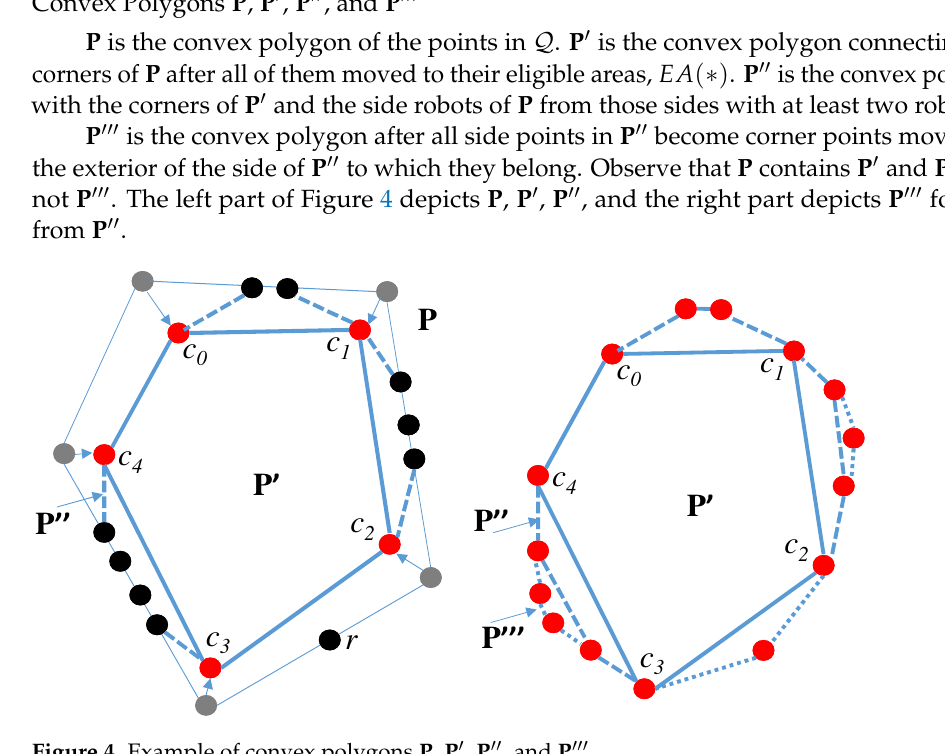
Figure 4. Example of convex polygons P , P (cid:48) , P (cid:48)(cid:48) , and P (cid:48)(cid:48)(cid:48)